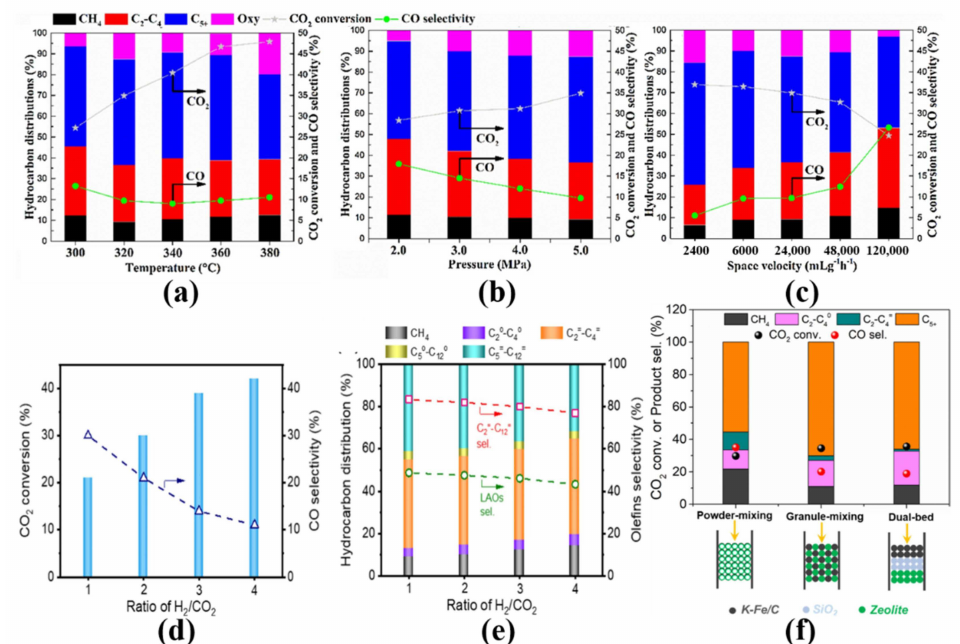
Figure 9. The catalytic performance of the K 3 /FeMn 10 Ti 20 catalysts under various conditions: tem- perature ( a ), pressure ( b ), and space velocity ( c ) in CO 2 hydrogenation (H 2 /CO 2 /Ar = 70.00 v%/ 25.03 v%/4.97 v%). Reprinted with permission from Zhao et al. [57]. Copyright (2021) Elsevier. Effects of H 2 /CO 2 on catalytic performance ( d ) and hydrocarbon distribution ( e ). Reaction condi- tions: 340 ◦ C, 2.5 MPa, GHSV = 15,000 mL · g cat–1 · h –1 , TOS = 10 h. Reprinted with permission from Zhang et al. [40]. Copyright (2022) Elsevier. ( f ) Effects of the mixing mode on the catalytic perfor- mance of a tandem catalyst coupled with K-Fe/C and zeolite. Reaction conditions: 320 ◦ C, 2.0 MPa, GHSV = 1200 mL · g cat − 1 · h –1 , H 2 /CO 2 = 2.5, mass ratio of K-Fe/C to zeolite = 1/3. Reprinted